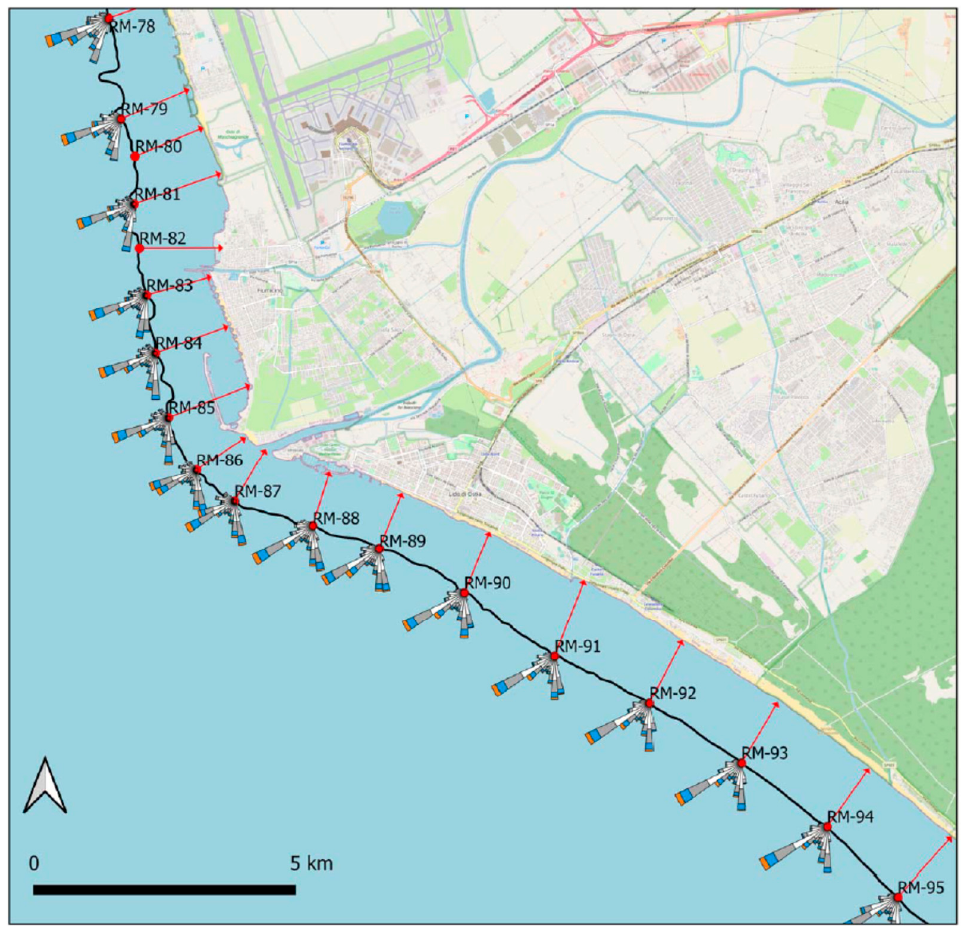
Figure 7. Nearshore wave roses along the Rome–Ostia coastal area—an example application to a portion of the model domain. Red arrows represent the local orthogonal to the coast. Table 2. Wave parameters at significant positions located at − 10 m (see Figure 7).